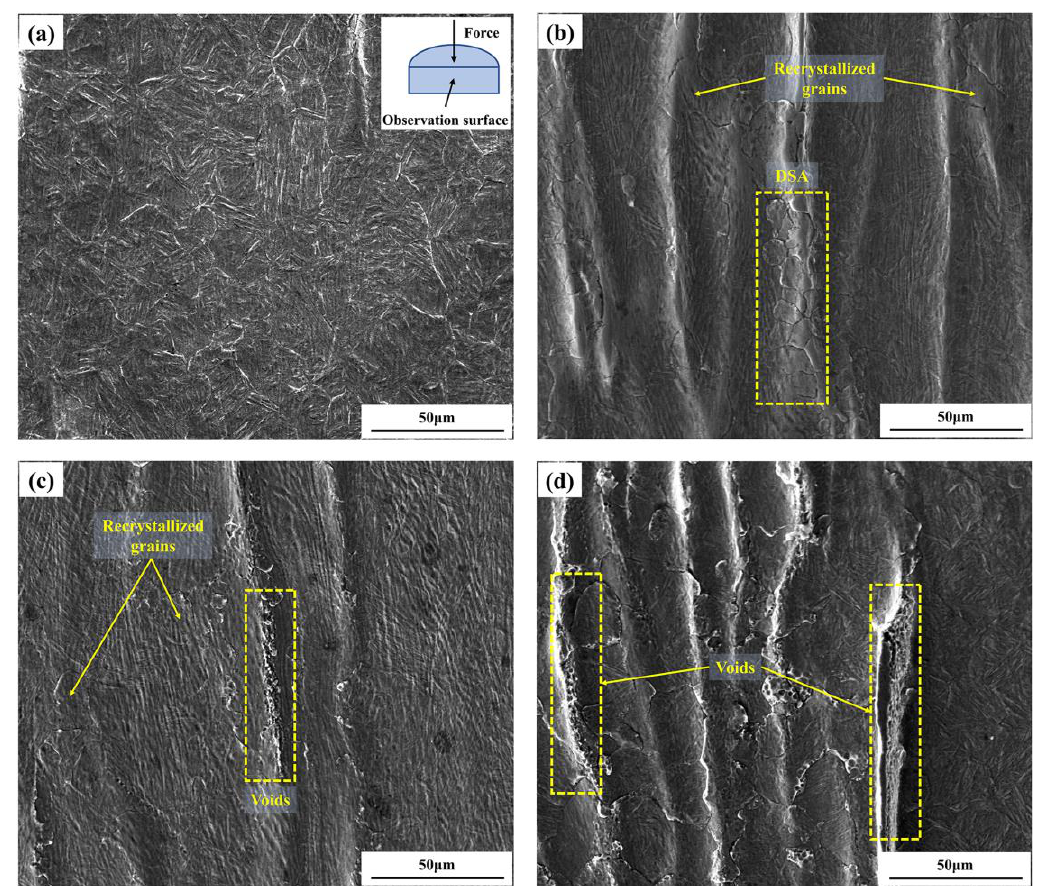
Figure 11. Microstructures of 30Cr4MoNiV ultra-high-strength steel in Ⅰ - Ⅳ areas: ( a ) Ⅰ (1273 K, 0.01 s −1 ); ( b ) Ⅱ (1323 K, 10 s −1 ); ( c ) Ⅲ (1223 K, 0.01 s −1 ); ( d ) Ⅳ (1373 K, 0.1 s −1 ).